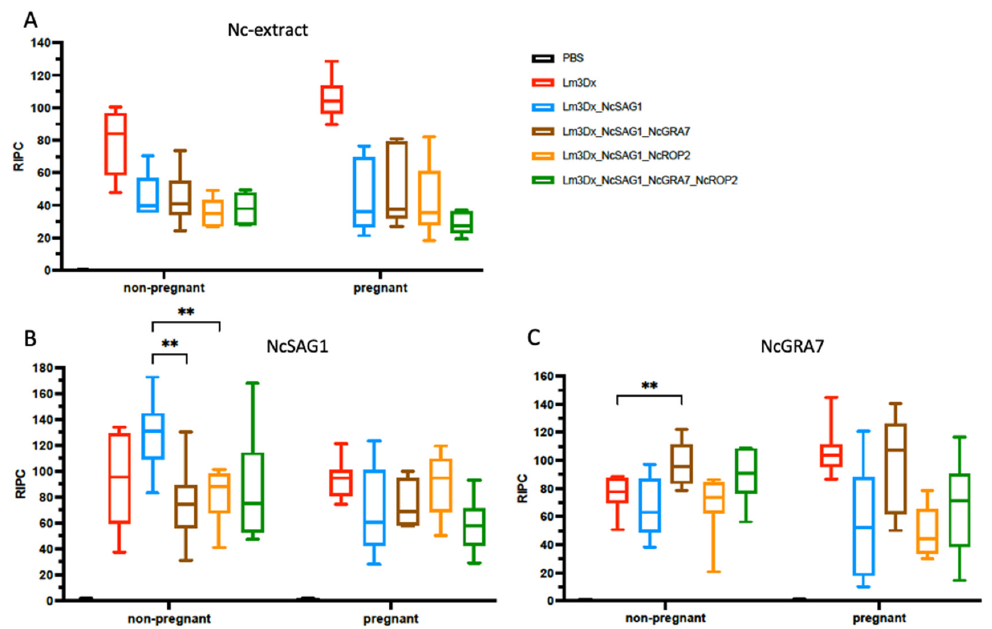
Figure 5. IgG responses of mice measured by ELISA against whole lysates of N. caninum tachyzoites ( A ) and against recombinant NcSAG1 ( B ) and NcGRA7 ( C ). Blood was collected at the endpoint (25 days post-partum). ** indicates statistically significant differences with p < 0.007. In order to further verify whether anti-ROP2 antibodies had been generated, recom- binant NcROP2 was assessed by Western blotting employing serum samples of mice vaccinated with Lm3Dx_NcSAG1_NcGRA7_NcROP2 (Figure 6). This showed that antibodies were produced at various amounts in the different mice. In non-pregnant animals, four out of eight mice exhibited ROPs staining, two with strong signals, and two only weakly positive. From the eight serum samples from the dams, three exhibited ROP2 labeling, although at a lower intensity (Figure 6B).